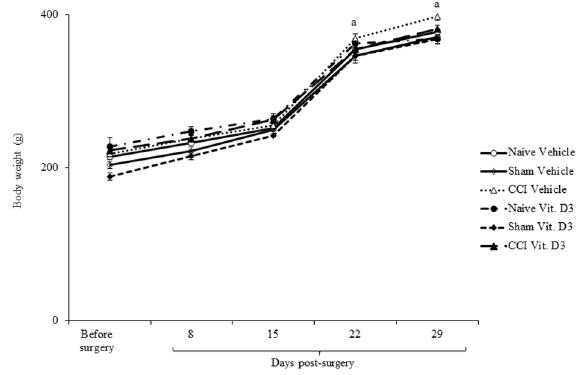
Figure 6. Body weight of rats treated with vitamin D 3 (Vit. D3) (500 IU/kg per day) or vehicle for 28 days after chronic constriction injury (CCI). Data are reported as means ± SE (n=6/ group). a P o 0.05 compared to values obtained before lesion and days 8 and 15 after surgery (two-way ANOVA followed by Tukey ’ s post hoc test). For Sham rats, all surgical procedures involved in the CCI were used except the